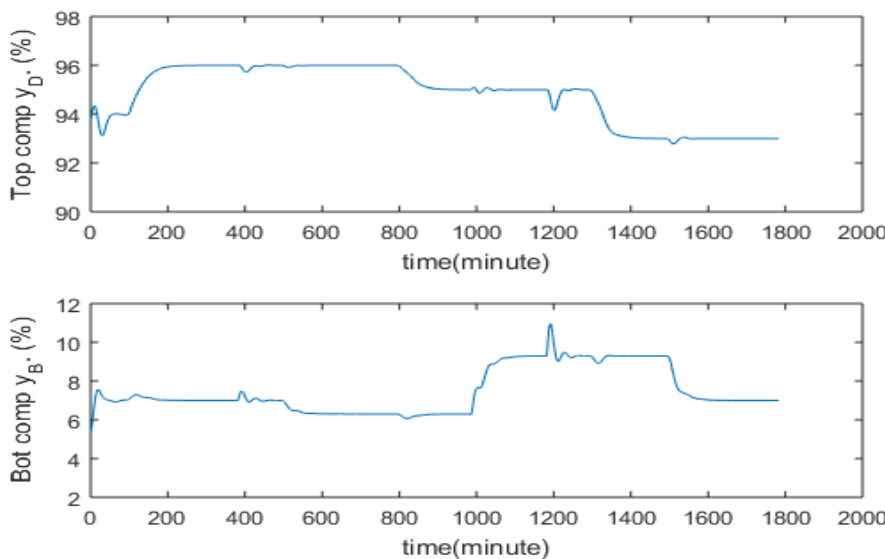
Figure 4. Top and Bottom product compositions.